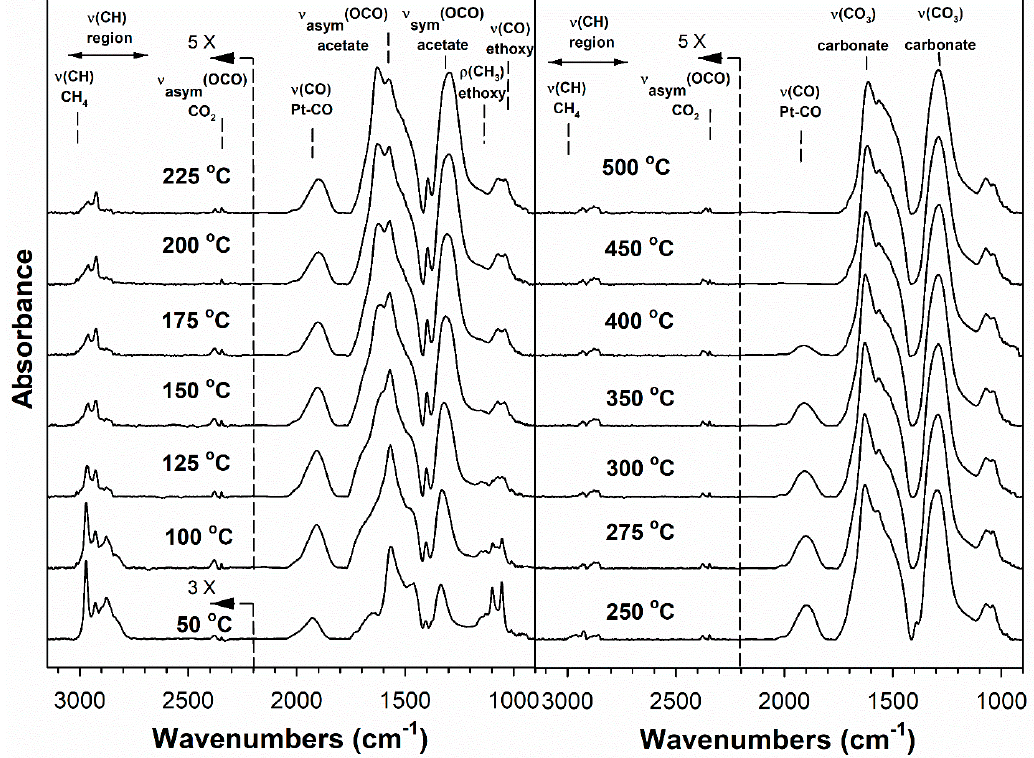
Figure 9. DRIFTS of transient ethanol steam reforming over 7.2% Cs-2% Pt/ZrO 2 .